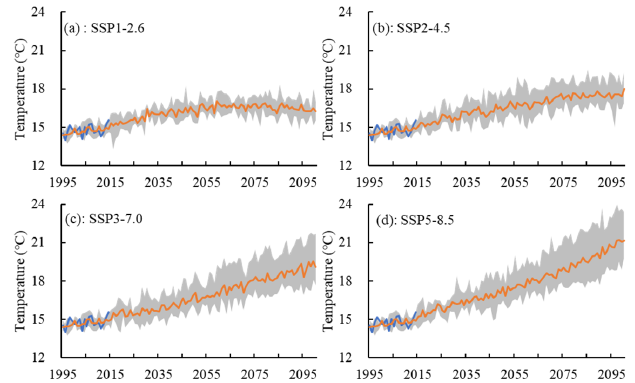
Figure 2. Historical variation and projection trend of temperature under SSPs scenarios ( a to d represent SSP1-2.6, SSP2-4.5, SSP3-7.0, and SSP5-8.5 respectively) for the Huai River basin (the blue solid line and the orange solid line are the recorded annual value and the ensemble mean of five GCMs projections, the grey area is the variation range of five GCMs projections, same to Figures 3– 6). Table 3. The tested results of temperature variation trend under different scenario for the Huai River basin.